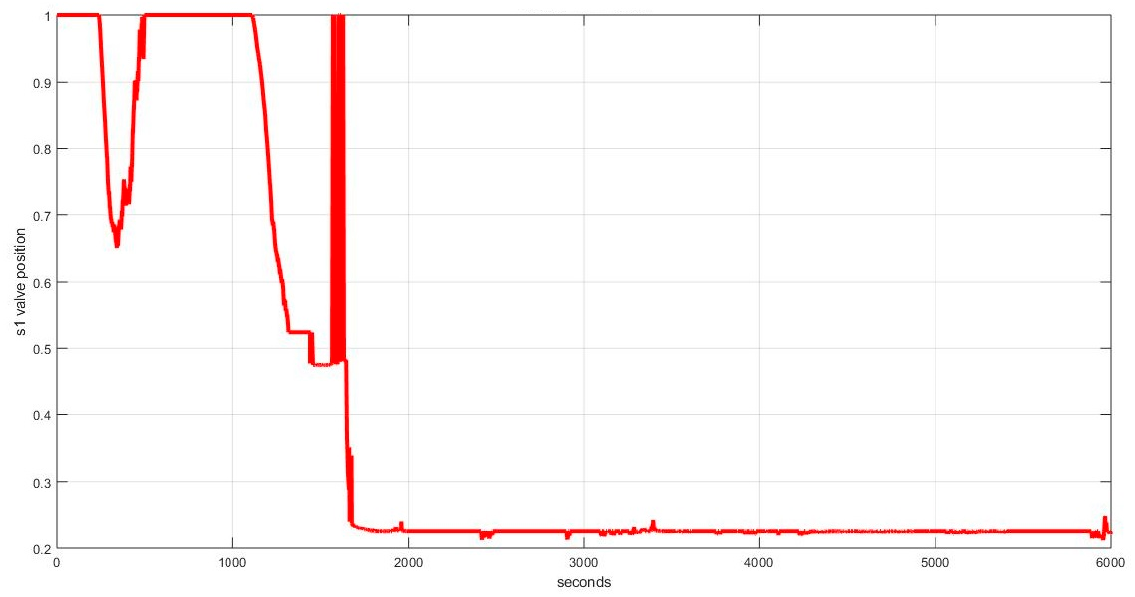
Figure 28. s1 control variable indicating the valve position for the case of a positive surge.